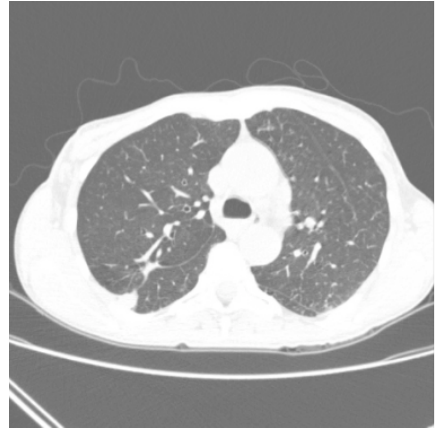
Figure 5: Local recurrence (arrow). Figure 6: Chest tomography at the hospital